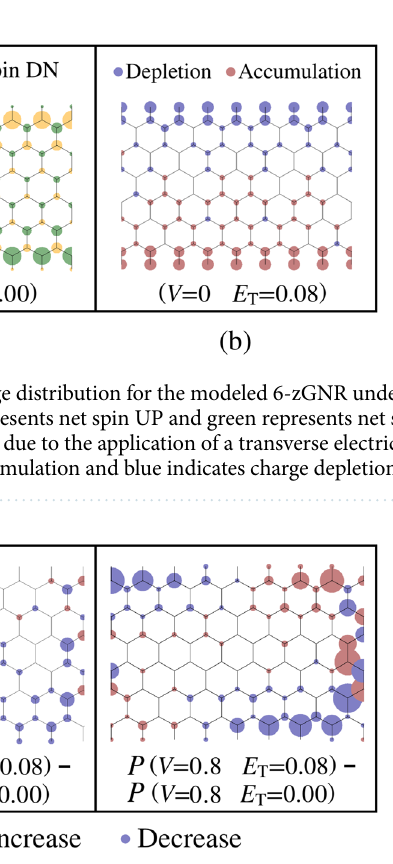
Figure 8. Change in the magnitude of of the spin moment ( P ) due to the application of transverse electric fields of magnitude: E T = 0.04 V / Å (left, at a bias voltage of 0.4V) and E T = 0.08V / Å (right, at a bias voltage of 0.8V). Red indicates an increase in the spin moment and blue indicates a decrease in the spin